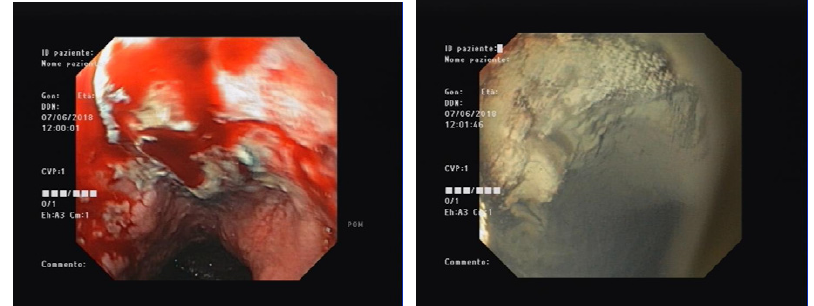
Figure 2. Esophageal cancer.